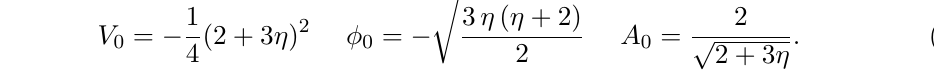
Figure 2. Plot shows longitudinal channel exponent (cid:23) k exists, i.e. lim ! ! 0 ! 2 (cid:23) k k (cid:0) 1 6 = 0.